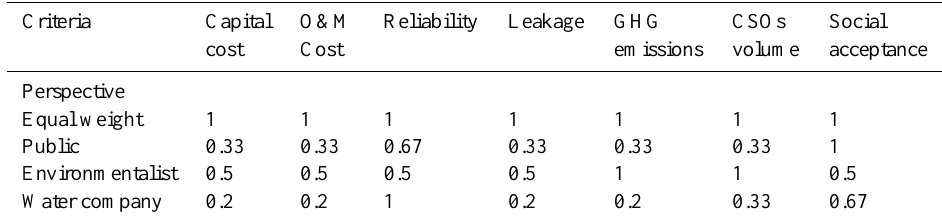
Table 1. Weights of the criteria from different perspectives.